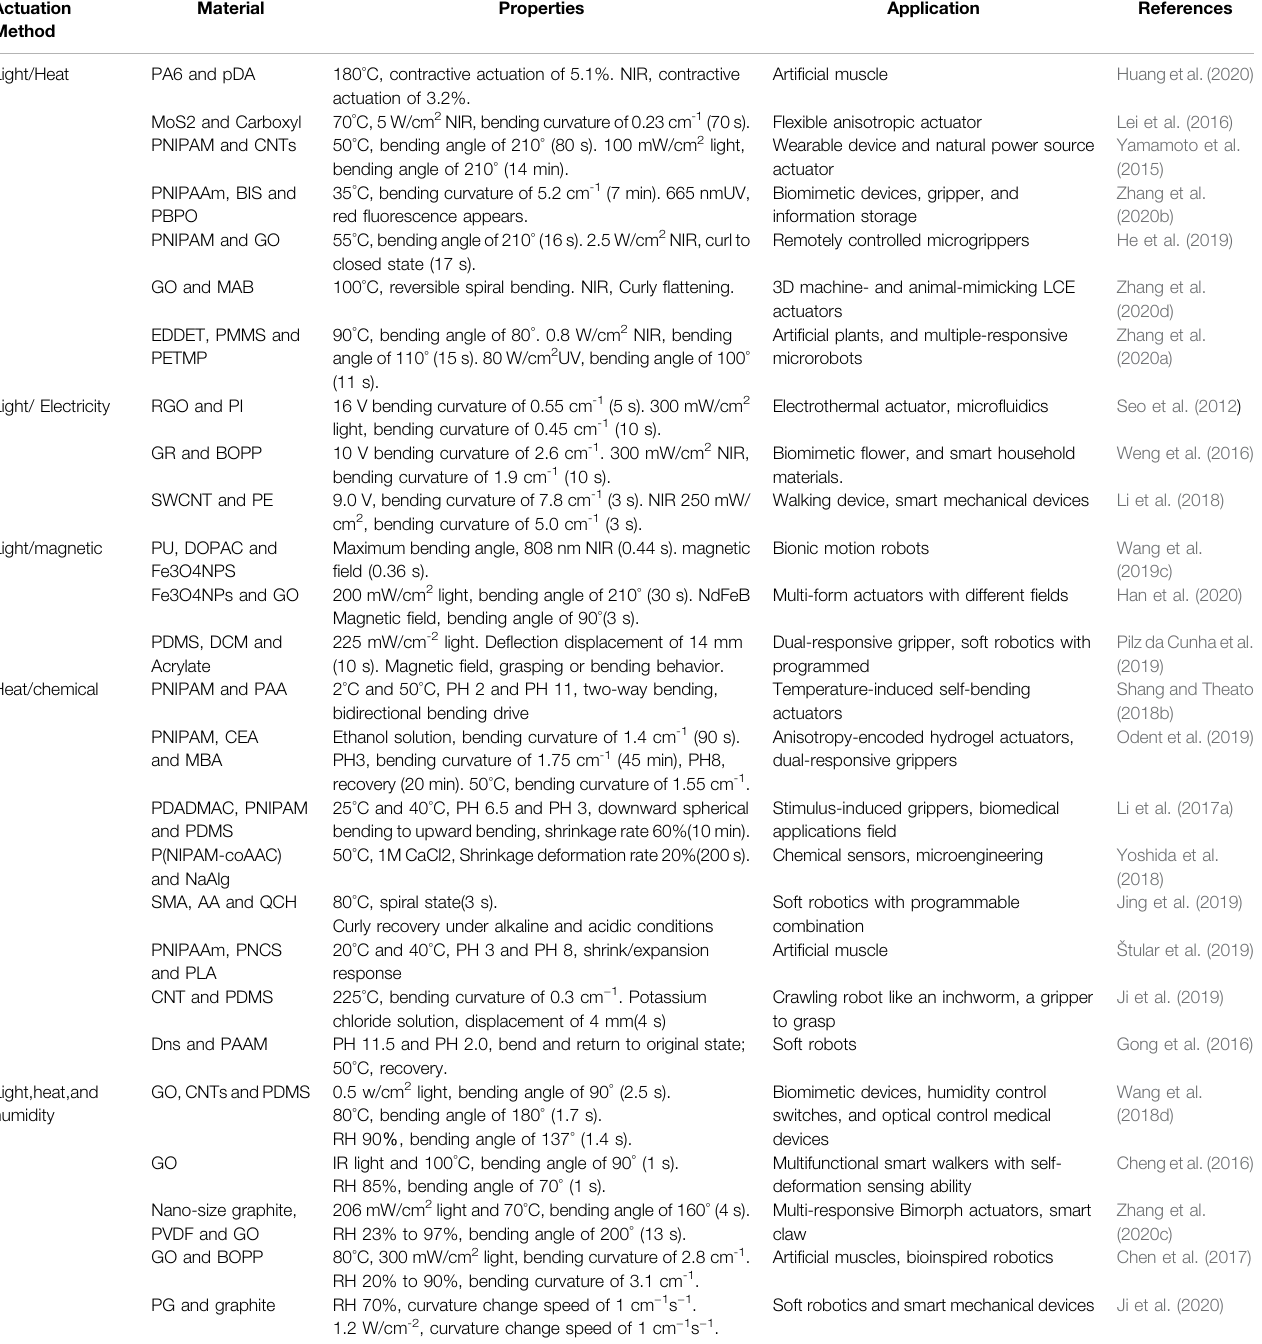
TABLE 2 | Feature of multiple response smart actuator based on multiple stimulus